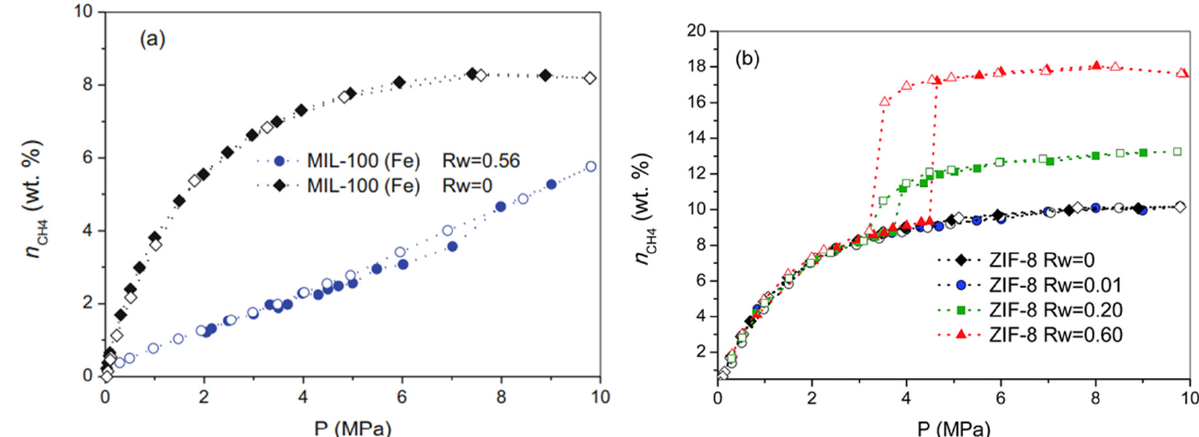
Figure 11. High ‐ pressure CH 4 adsorption/desorption isotherms (275 K and up to 100 bar): ( a ) Hydrophilic framework of MIL ‐ 100 (Fe) (dry and wet); ( b ) Hydrophobic framework of ZIF ‐ 8 (dry and wet). Wet conditions correspond to different water contents (Rw is the amount of water in g/g) [57] (Reprinted from [57] due to open access permission).